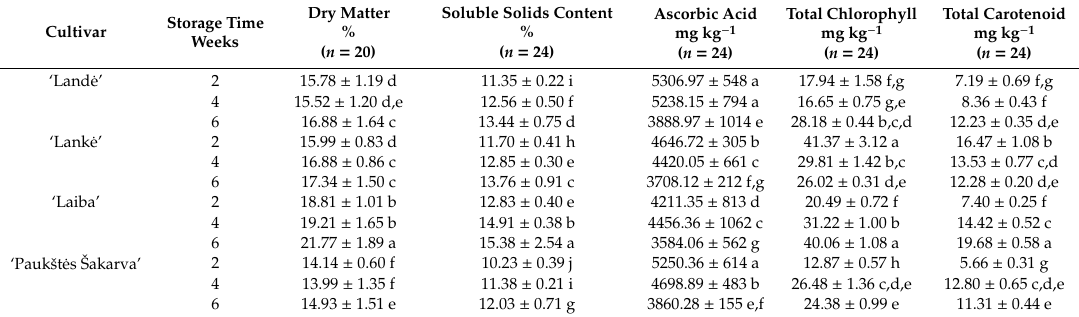
Table 2. Dependence of the chemical composition of Actinidia kolomikta fruit on cultivar and storage time.